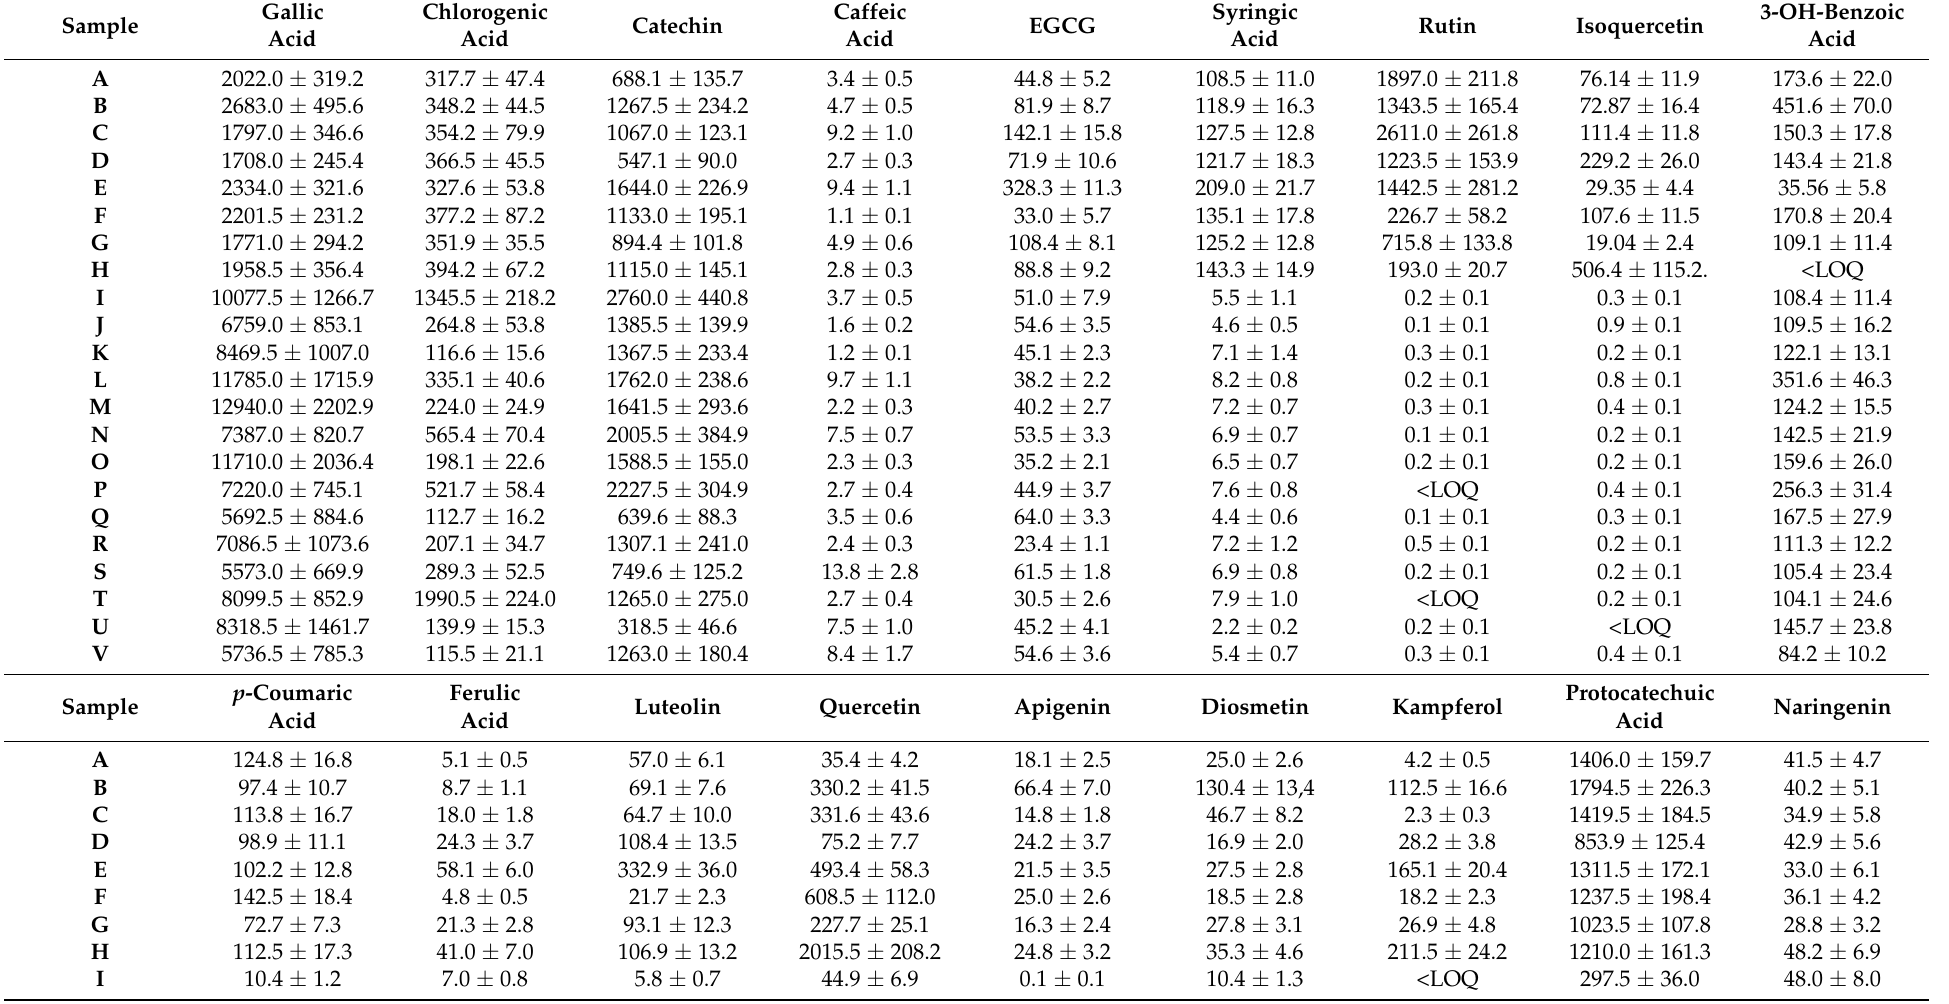
Table 4. Phenolic compounds identified and quantified in hazelnut shell extracts. Data are reported as µ